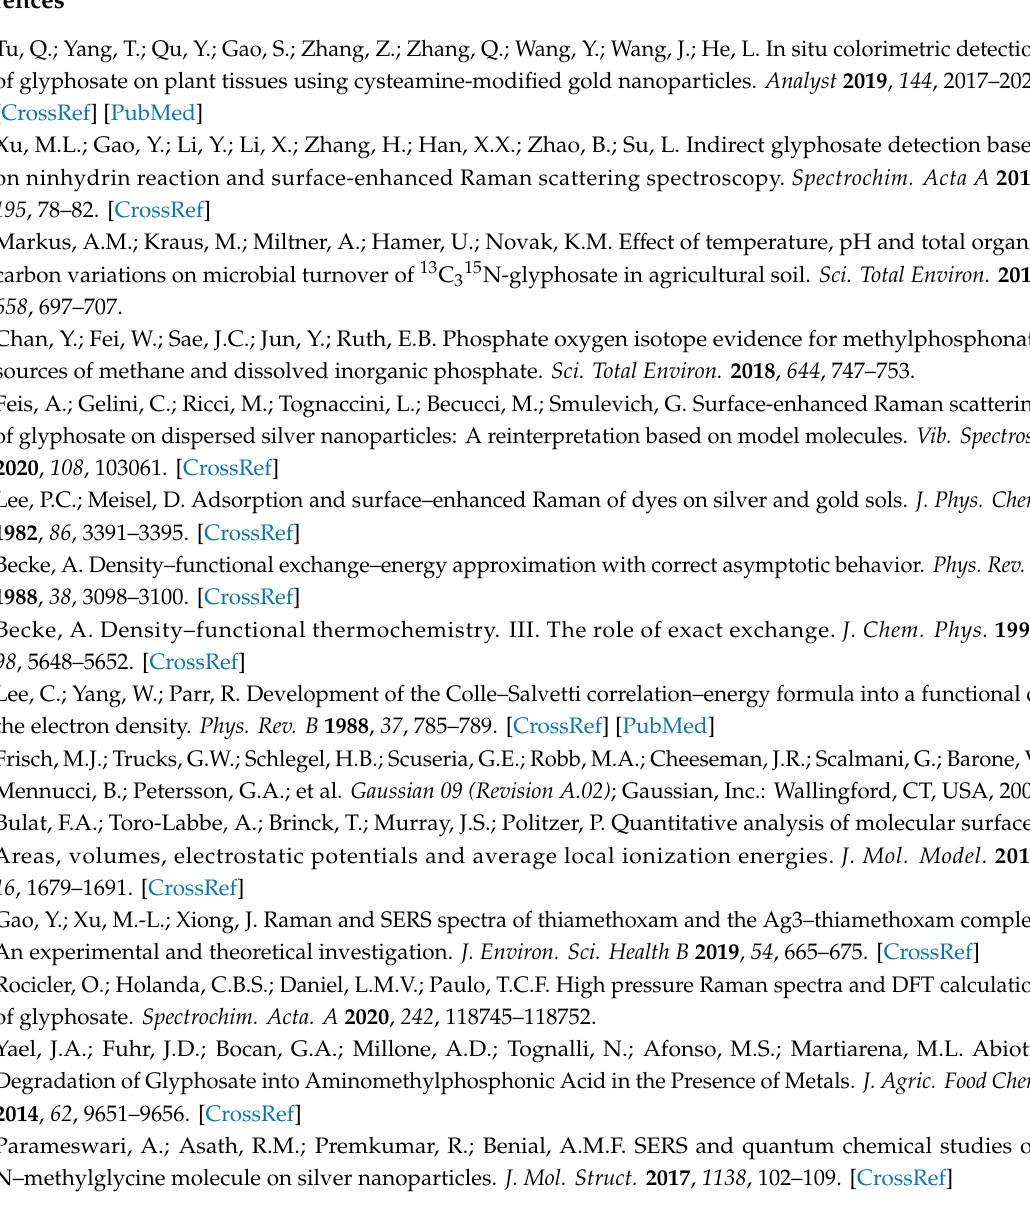
Figure S1: UV-Vis spectrum of the Ag NPs, Table S1: The optimized structural parameters of 2-13C-glyphosate or glyphosate calculated at the B3LYP / 6-311 + G** level, Table S2: Calculated and normal Raman spectra of glyphosate (12-GLY) and 2-13C-glyphosate (13-GLY) in the frequencies, Table S3: Raman and SERS band assignments (cm − 1) of the Purple Color Dye (PD) product from glyphosate (12–GLP) and 2-13C-glyphosate